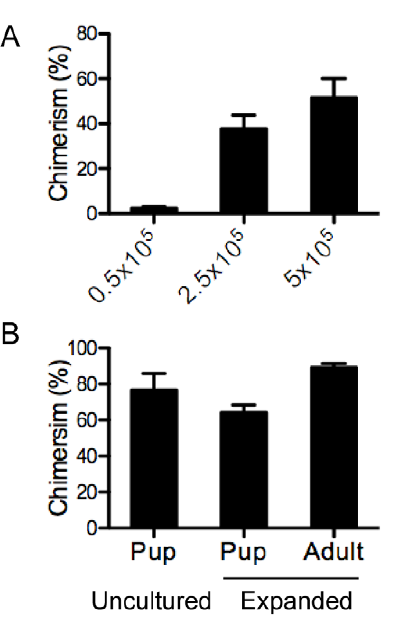
Figure 3. Expanded CD34 + CD133 + cells give robust reconsti- tution in both neonate and adult recipients. (A) Comparison of reconstitution levels in mice injected with different numbers of expanded cells. Sub-lethally irradiated adult NSG recipients were injected with cultured cells containing 0.5 6 10 5 , 2.5 6 10 5 or 5 6 10 5 CD34 + CD133 + cells. Eight weeks later, PBMCs were analyzed for human and mouse CD45 expression. Mean 6 SD is shown, n=6–8 per group. (B) Comparison of reconstitution levels in the bone marrow of neonate and adult recipients. Sub-lethally irradiated adult NSG recipients were injected with expanded cells containing 2.5 6 10 5 CD34 + CD133 + cells. Sub-lethally irradiated neonates were injected with 1 6 10 5 unexpanded or expanded CD34 + CD133 + cells. Twelve to sixteen week later, bone marrow was analyzed for human and mouse CD45 expression. Mean 6 SD is shown, n=4–6 per